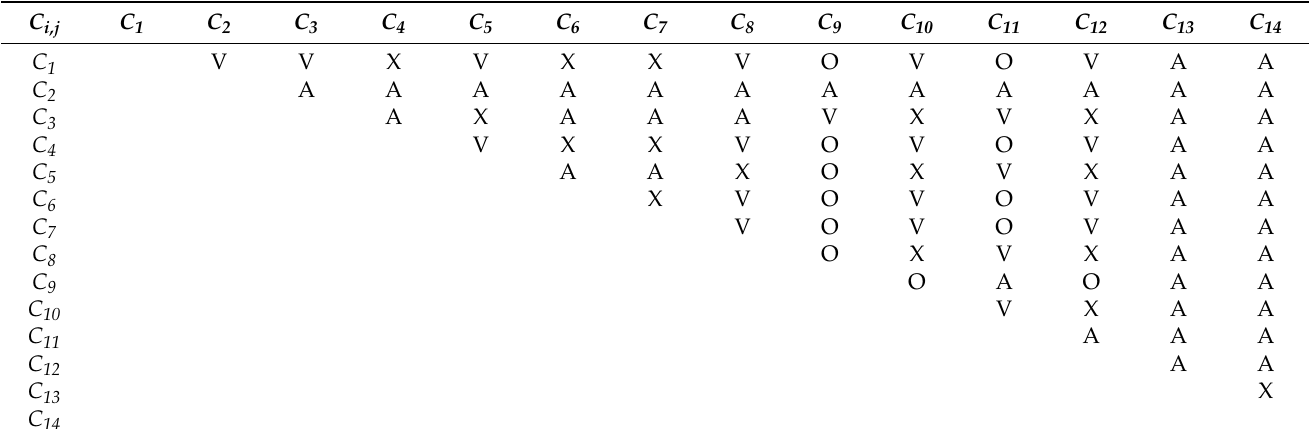
Table 3. Structural Self-Interaction Matrix (SSIM) of critical Systems-Thinking-based leadership competencies as enablers to better construction safety